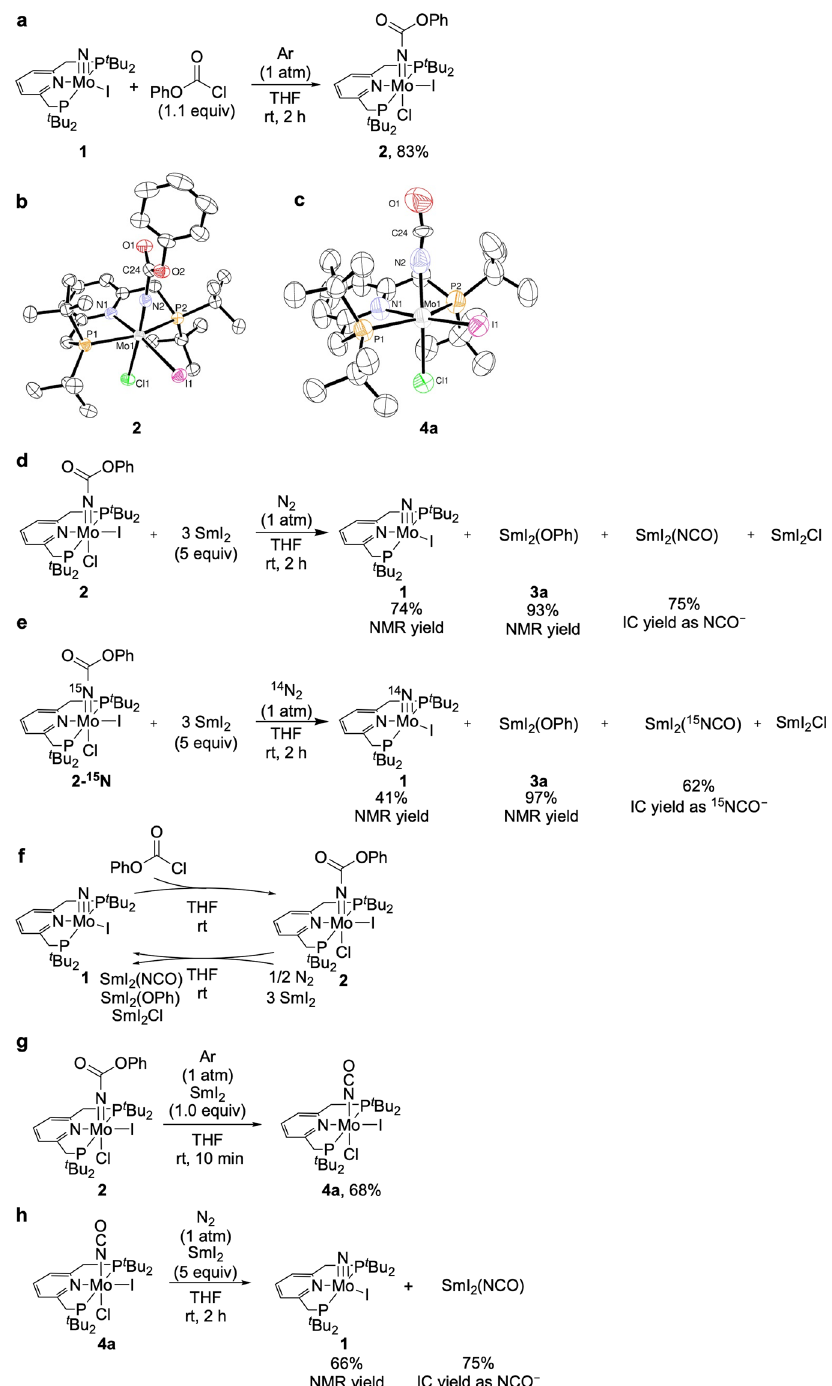
Fig. 3 | Stoichiometric reactions for isocyanate derivatives from dinitrogen. a Synthesis of carbamate complex 2 . b , c ORTEP drawings of 2 ( b ) and 4a ( c ). Thermalellipsoids are shownatthe 50%probability level.All hydrogenatoms and solvent molecules are omitted for clarity. d Reduction of 2 with an excess amount